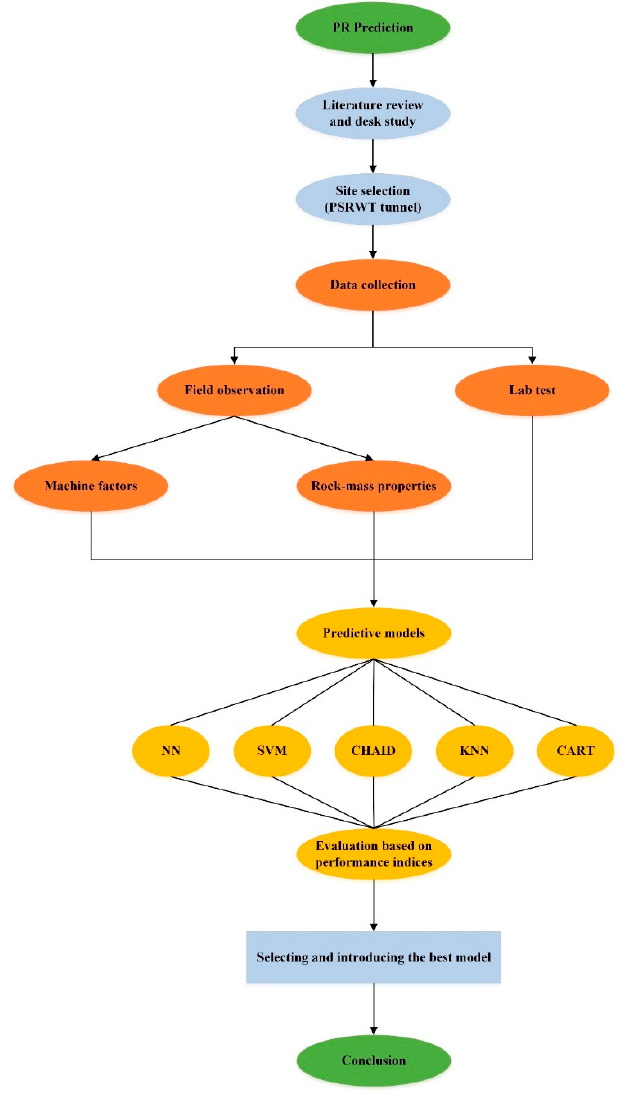
Figure 5. The detailed flowchart of this study in predicting TBM penetration rate (PR).